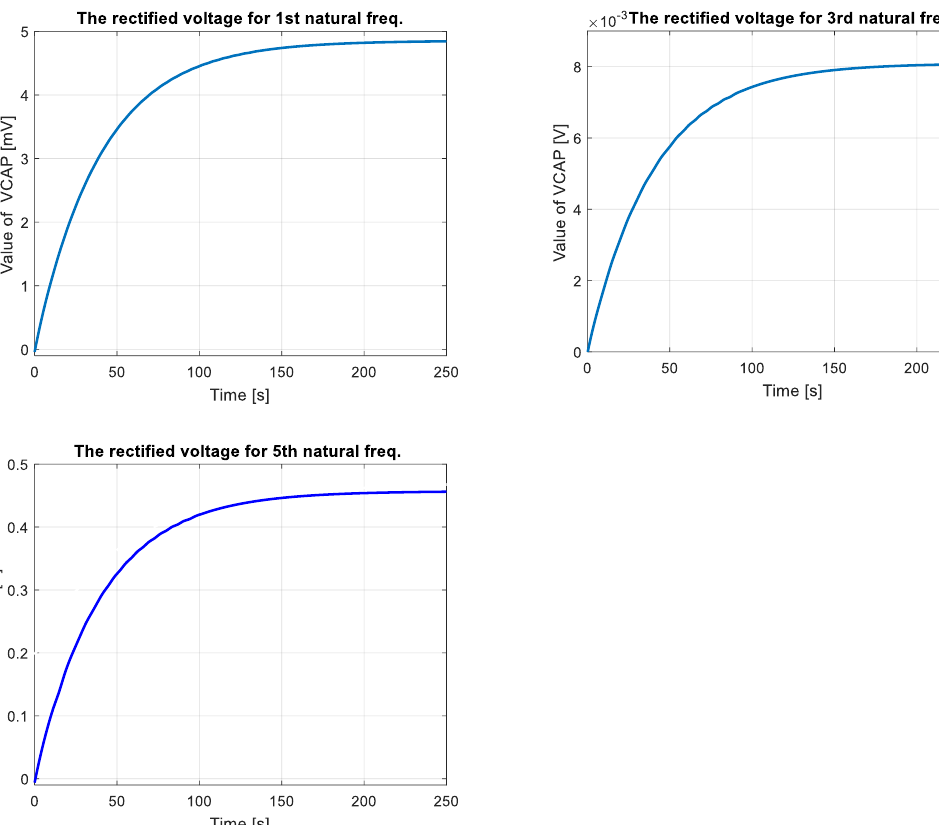
Figure 8. The rectified voltage from a full bridge rectifier with a smoothing capacitor C p = 400μF and resistive load R = 100kΩ obtained for the SFSF smart plate excited to vibration with the first three odd lowest natural frequencies.